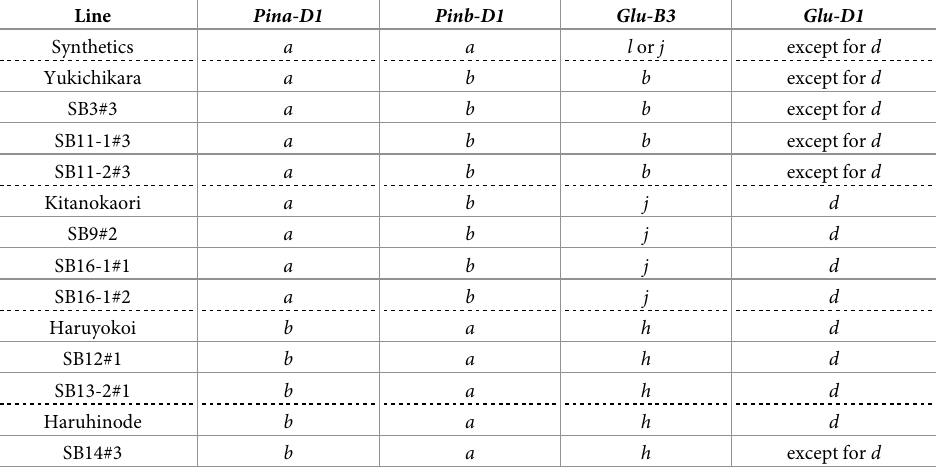
Table 4. PCR-based genotyping of the Pin and Glu alleles in the selected early flowering lines and their four parental cultivars. Line